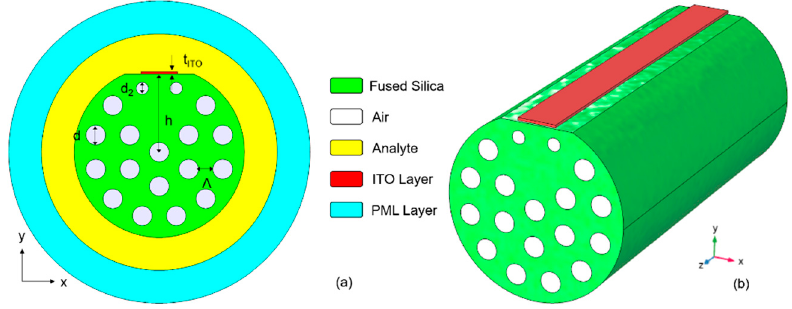
Figure 1. ( a ) Cross section of the proposed MPF–SPR sensor and ( b ) its three-dimensional view.